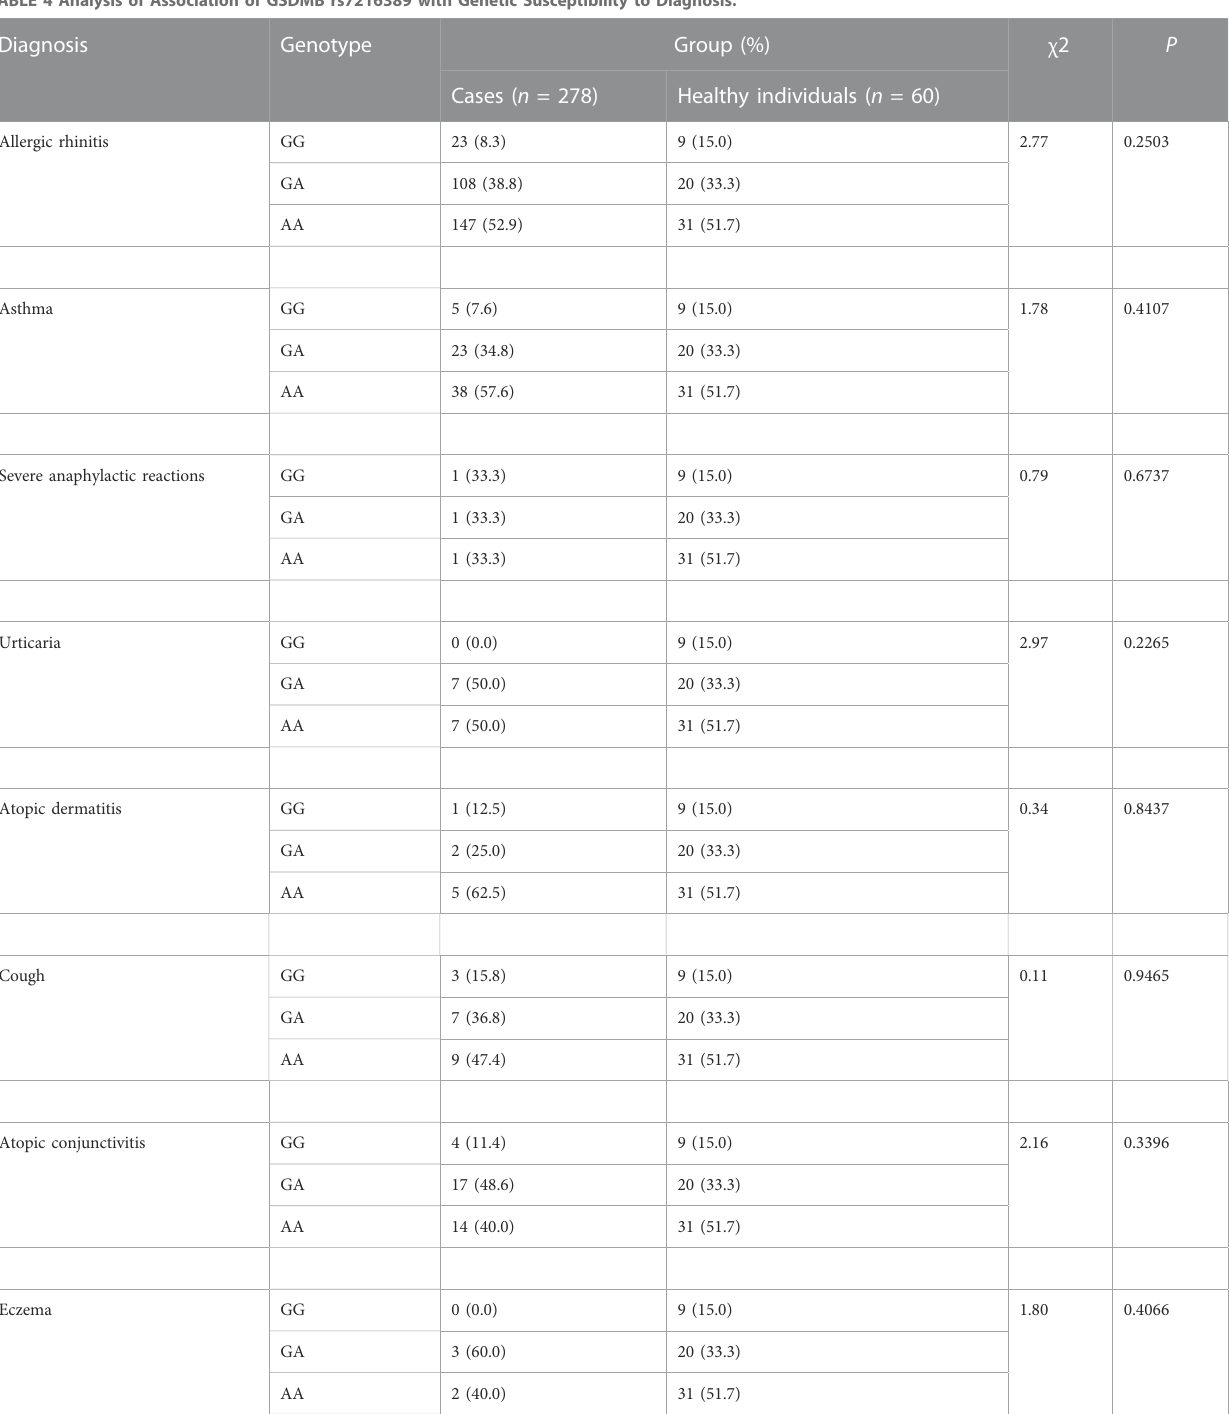
TABLE 4 Analysis of Association of GSDMB rs7216389 with Genetic Susceptibility to Diagnosis.